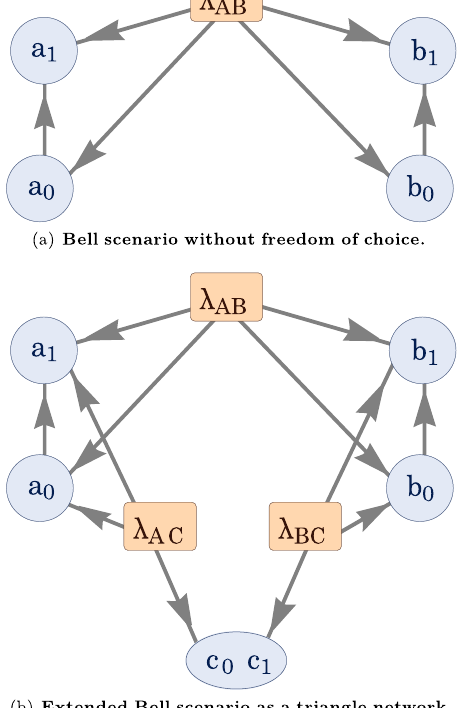
Fig. 7 | Triangle scenario from extended Bell scenario. a Extended Bell scenario with measurement dependence. Relative to the standard Bell scenario, the source fl uence not only the outcomes a λ 1 and b 1 , but the setting AB is presumed to in variables a 0 and b 0 as well. This allows for measurement dependence and can describe superdeterministic models 73 . b Extended Bell causal structure with mea- surement dependence mapped into the triangle scenario. Relative to the standard Bell scenario, one posits an additional laboratory, associated to Charlie, an addi- tional source λ AC between Alice and Charlie and an additional source λ BC between Bob and Charlie. Correlations between a 0 and c 0 , c 1 imply an upper bound on the potential dependence of a 0 on λ AB , described by the entropic inequality in Eq. (8). Similarly,correlationsbetween b 0 and c 0 , c 1 implyanupperboundonthepotential dependence of b 0 on λ AB .